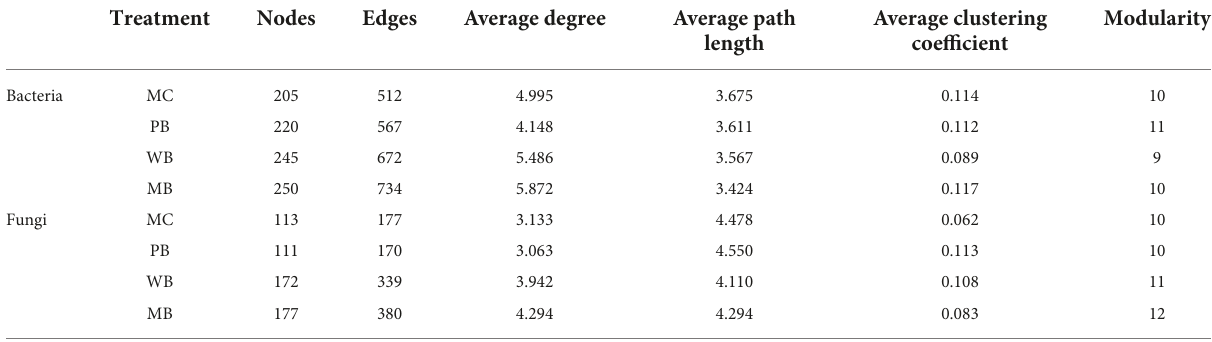
TABLE 4 Topological properties of co-occurrence network of rhizosphere soil following organic amendment at 20 t ha − 1 . Treatment Nodes Edges Average degree Average path